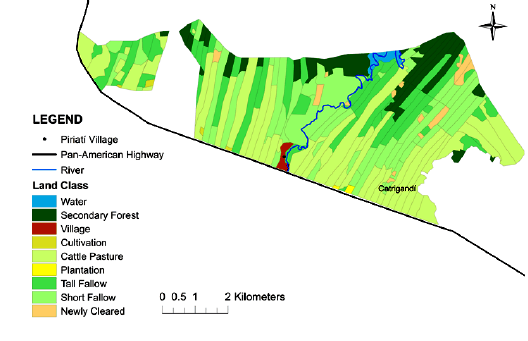
Fig. 2 . Participatory map of the community land (tierras colectivas) of